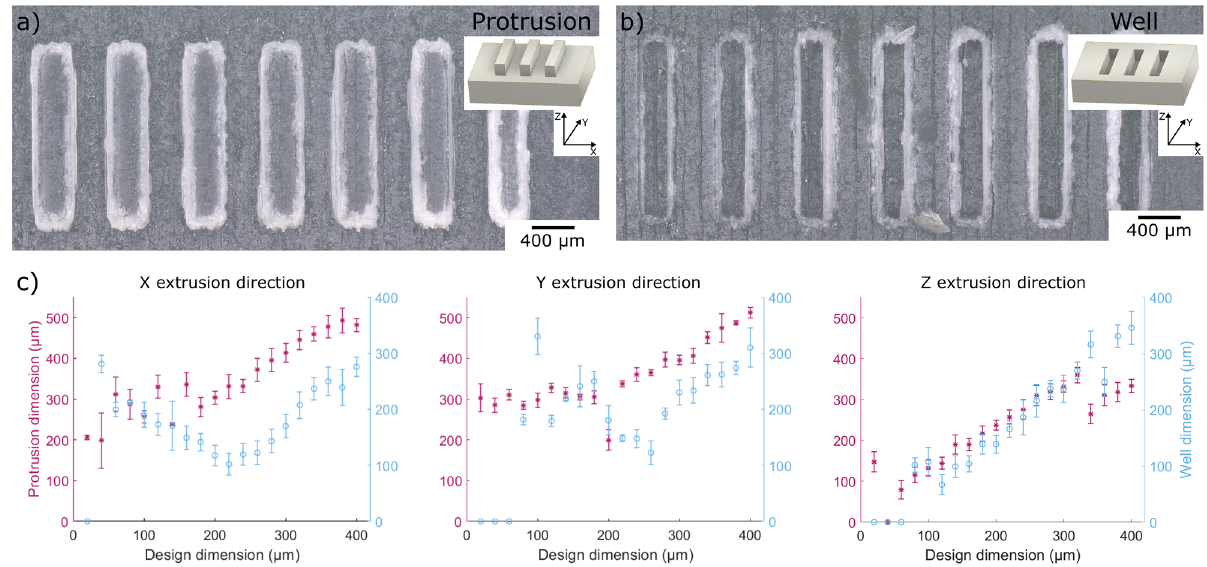
Figure 1. Calibration of the printing resolution of the 3D printer. Test structures were designed using a CAD software and 3D printed using Projet MJP2500 Plus Multijet printer. Example microscope images of the 3D printed periodic structures such as ( a ) protrusions and ( b ) wells with a designed width of 360 µ m . Insets show the schematic of the structures and the extrusion directions. ( c ) The dimensions of the 3D printed target features were measured and plotted as a function of the design dimension for the three different extrusion directions. Error bars correspond to ± 1 standard deviation.